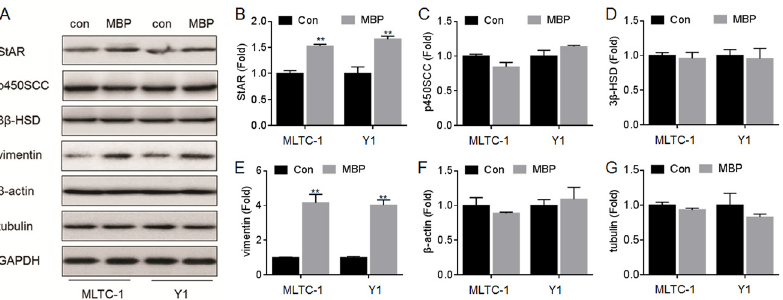
Fig 3. Effects of MBP on the expressions of StAR, p450scc, 3 β -HSD, vimentin, β -actin, and tubulin. MLTC-1 and Y1 cells were treated by 1000 nM MBP for 24 h. (A) Western blots analysis and relative protein levels of (B) StAR, (C) p450SCC, (D) 3 β -HSD, (E) vimentin, (F) β -actin, and (G) tubulin. ** p < 0.01 compared with medium control cells.